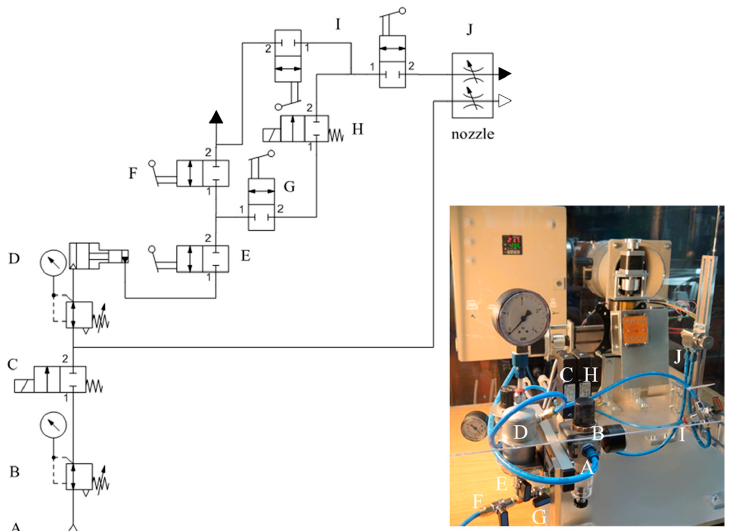
Figure A1. Pneumatic/Hydro plan of the spray deposition system for GNP strain gauges fabrication